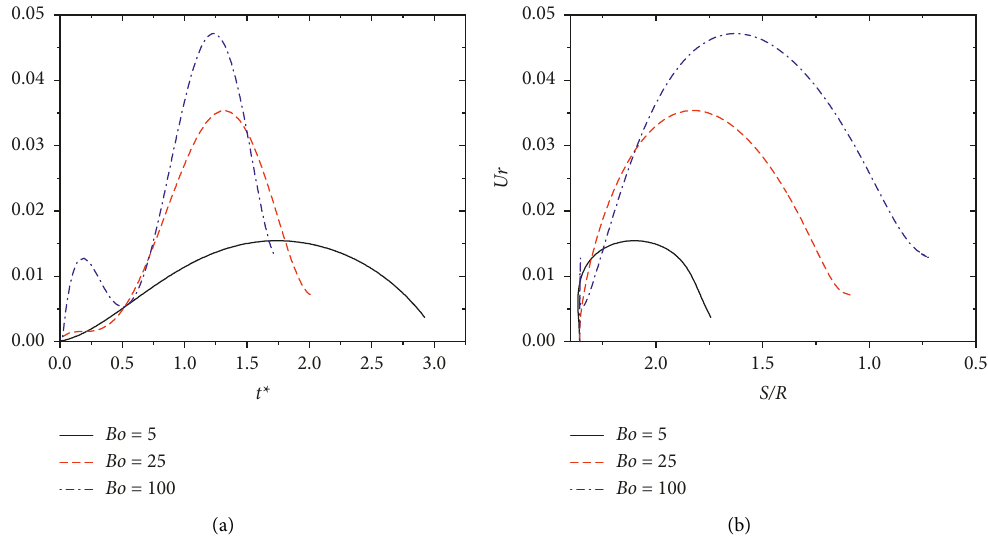
Figure 11: The effect of Bo on the instantaneous relative velocity at Ar � 25. (a) Relative velocity versus time; (b) relative velocity versus bubble center